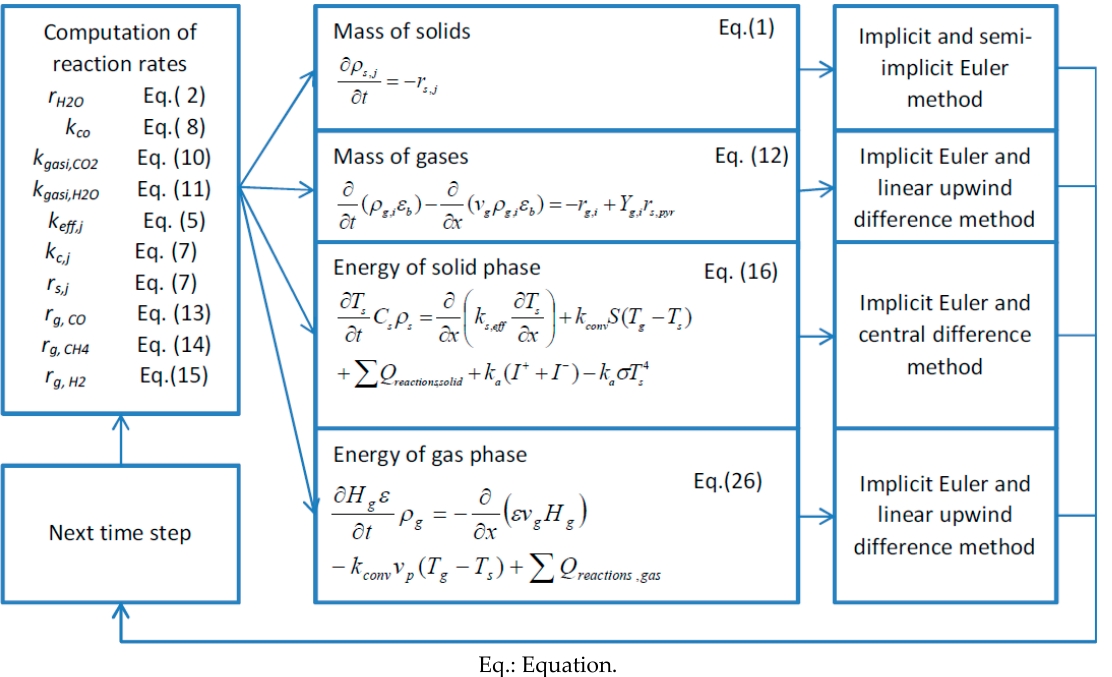
Figure 2. Outline of the model used for process phenomena investigation.